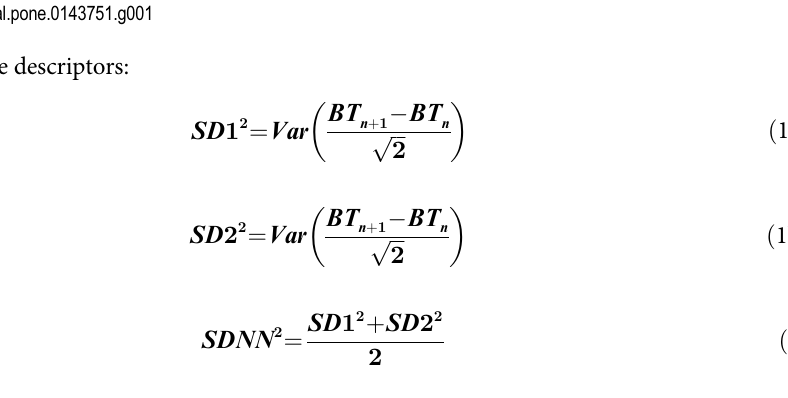
< BT n ). BT n : BT of the current value, BT n